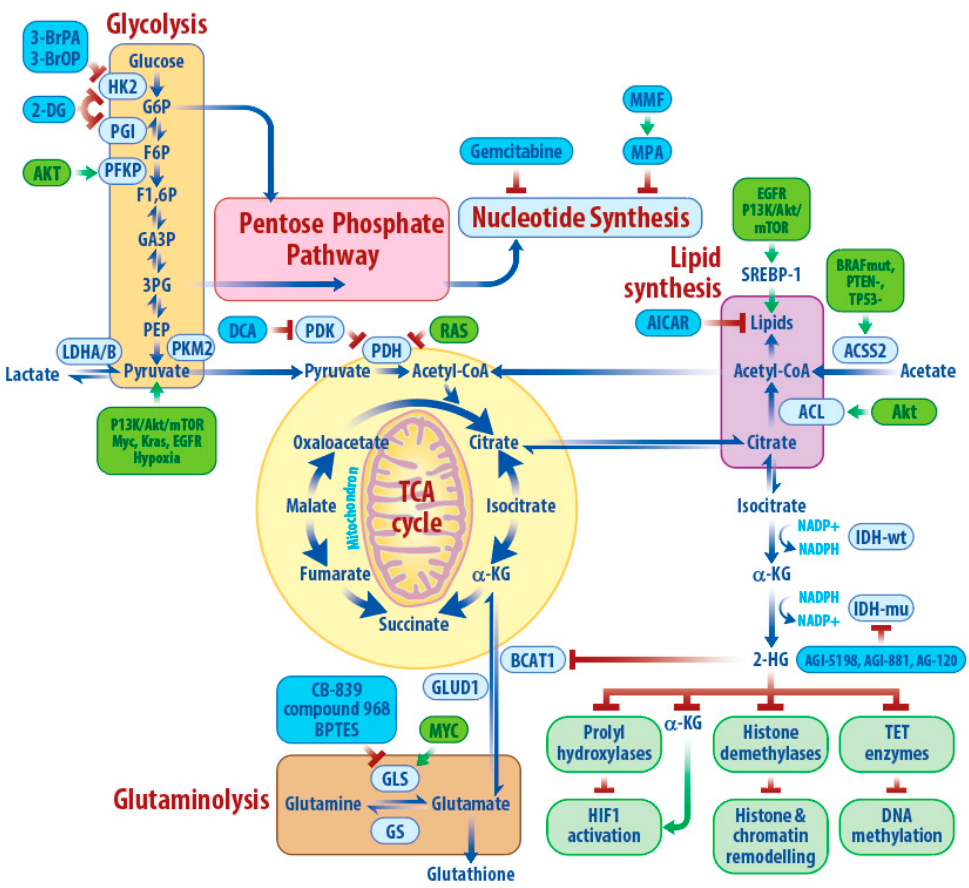
Figure 2. Key metabolic remodeling and potential therapeutic targets in glioblastoma (GBM). Metabolic reprogramming involved in GBM includes glycolysis, TCA cycle, glutaminolysis, pentose phosphate pathway (PPP), lipid and nucleotide synthesis, and D-2HG pathways. Key enzymes (light blue box) of these pathways can be regulated by known oncogenic signaling pathways (green box) and be targeted (dark blue box) for the treatment of GBM. Note: Blue arrows indicate metabolic conversion; dark red arrows indicate inhibition and green arrows indicate stimulation or activation.